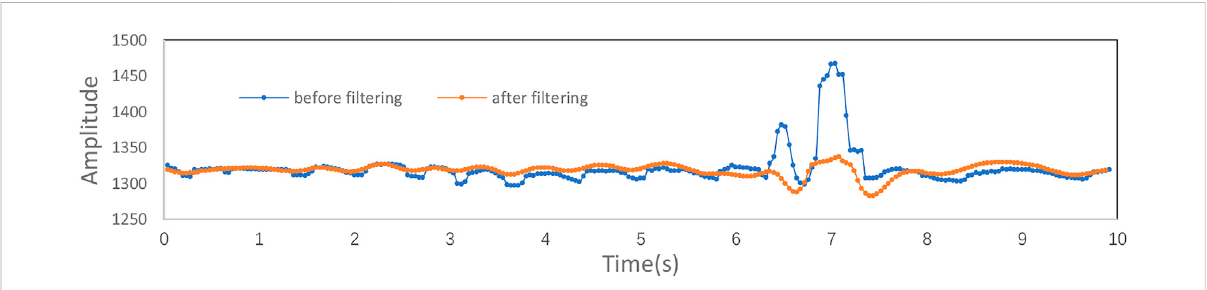
FIGURE 6 Comparsion before and after signal fi ltering.